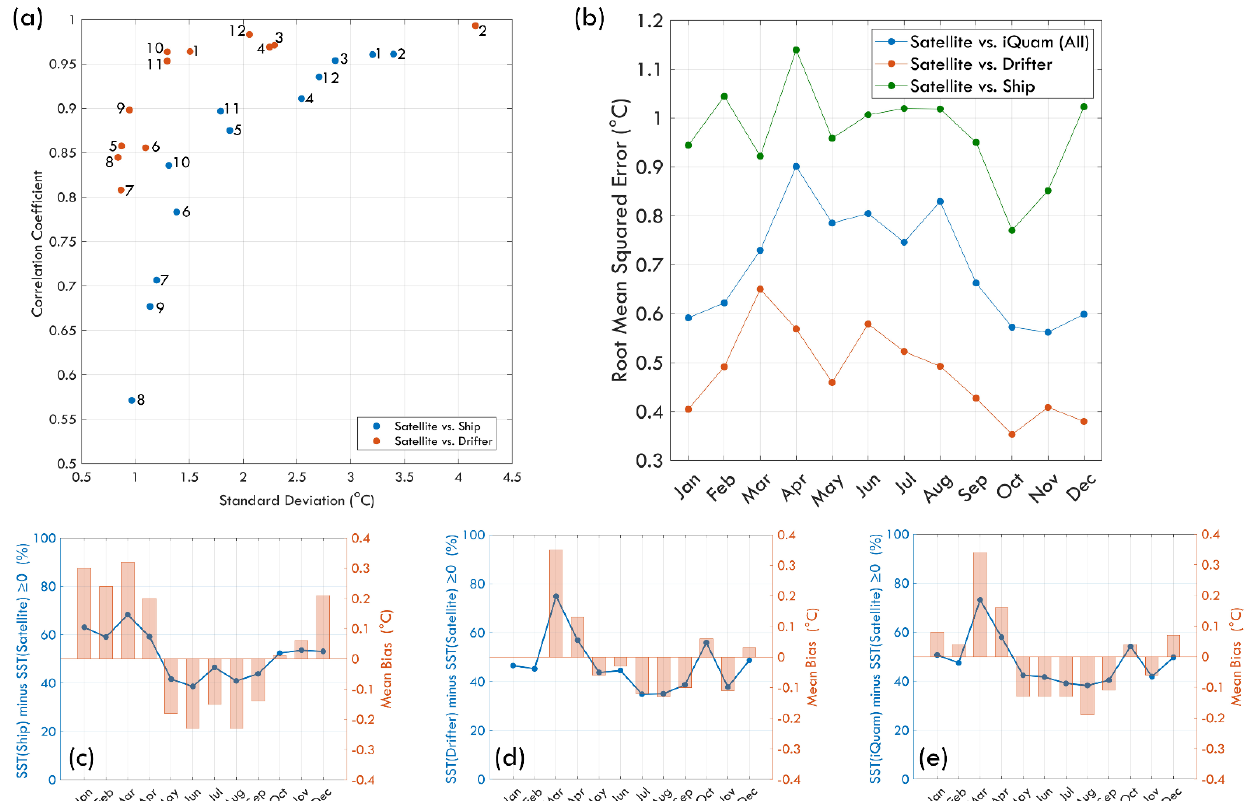
Figure 3. Comparison of bulk SST and skin SST on a monthly time scale: (a) comparison of satellite skin SST and bulk SST of drifter and ship for each month, (b) the RMSE between skin SST and bulk SST, and the percentage of data that bulk SST is greater than skin SST and the mean bias between (c) ship and satellite, (d) drifter and satellite, and (e) iQuam dataset and satellite.